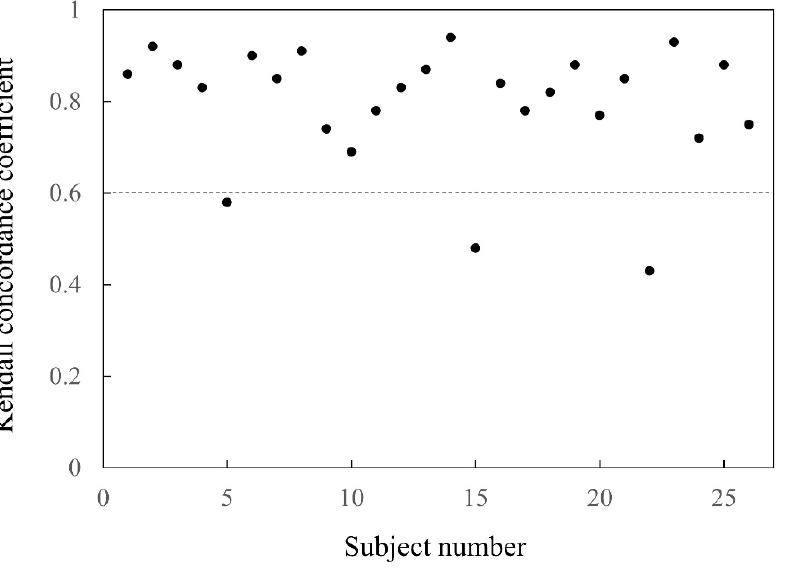
Figure 12. Kendall concordance coefficient of each subject.